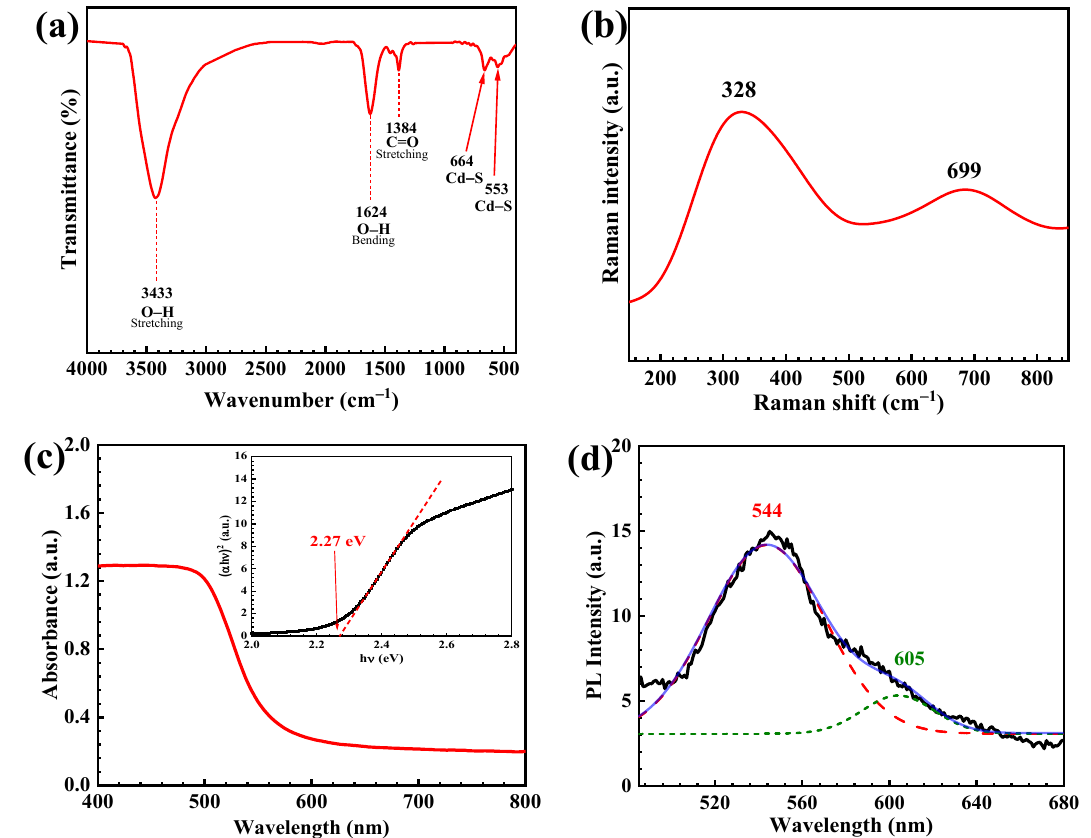
Figure 3. FT − IR spectrum ( a ), Raman spectrum ( b ), diffused reflectance spectrum ( c ) with a Tauc plot for determination of energy band gap (inset plot) and PL spectrum ( d ) of the CdS nanoparticles using an excitation wavelength of 355 nm.